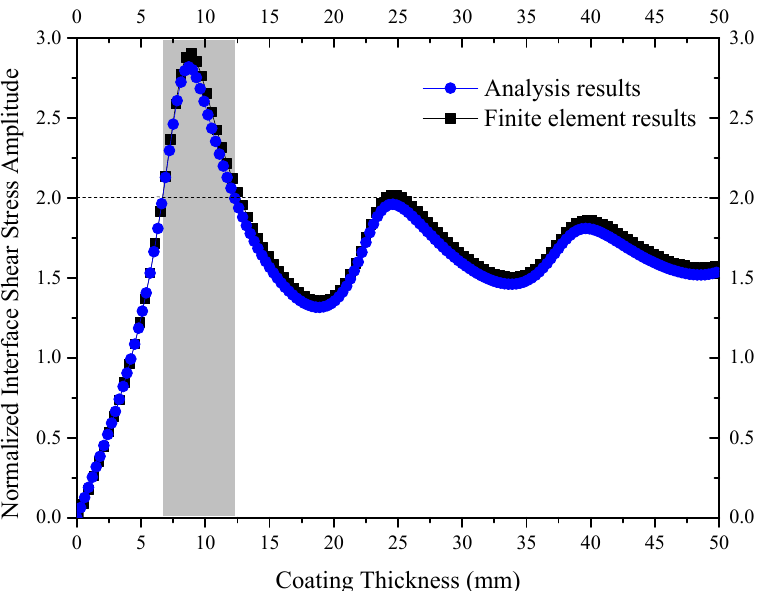
Figure 3. The analytical result and the finite element result of normalized interfacial shear stress